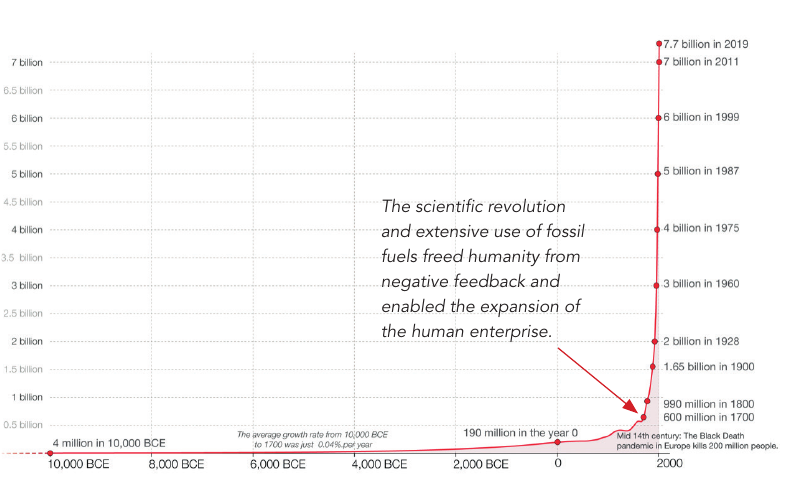
Source of population graph: